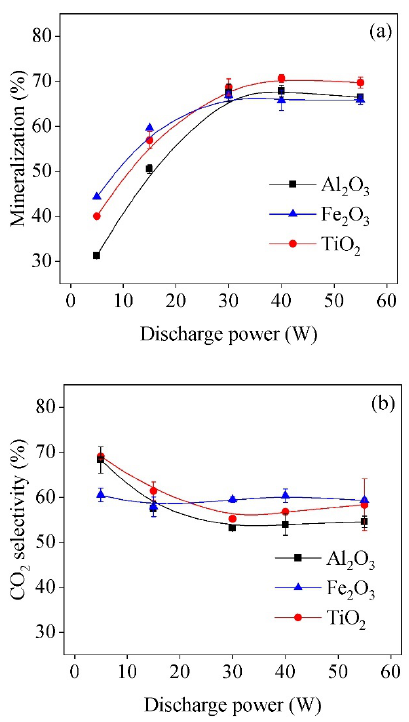
Figure 8. Effect of discharge power on ( a ) the mineralization and ( b ) the CO 2 selectivity in the DBD reactor filled with Al 2 O 3 , Fe 2 O 3 , and TiO 2 . (Driving frequency: 12.6 kHz; initial naphthalene concentration: 21.5 ppm; total gas flow rate: 500 mL/min; discharge gap: 3 mm). However, when the discharge power was not higher than 30 W, the CO 2 selectivity decreased with the increase in discharge power in the DBD reactors filled with TiO 2 and